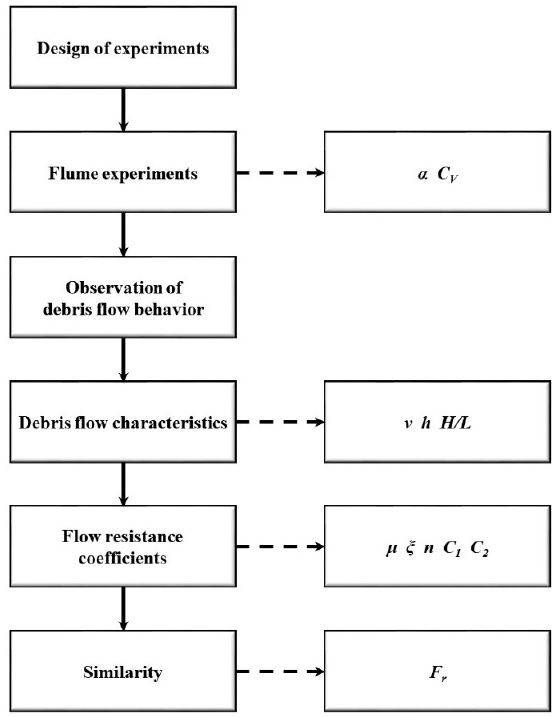
Figure 5. Flow chart of flume experiments.